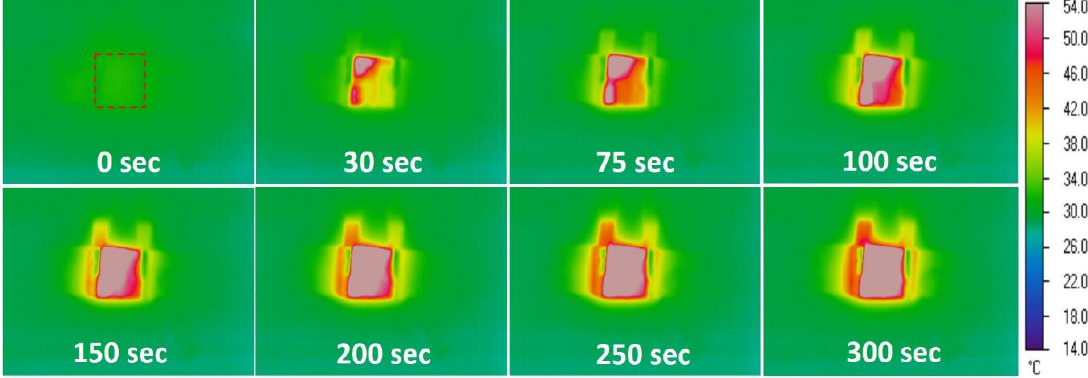
Figure 5. Heat profile of CNT/PU coatings due to the Joule heating effect.